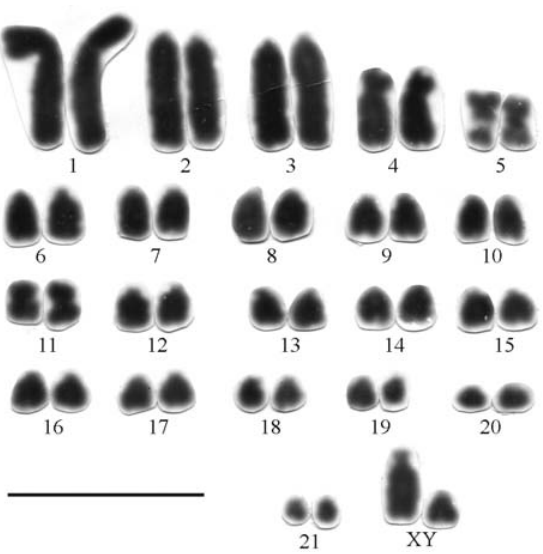
Figure 11 - Karyotype conventionally stained with 2n = 44, FN = 52 of Proechimys sp . from Manaus (AM). Bar = 10 (cid:1)